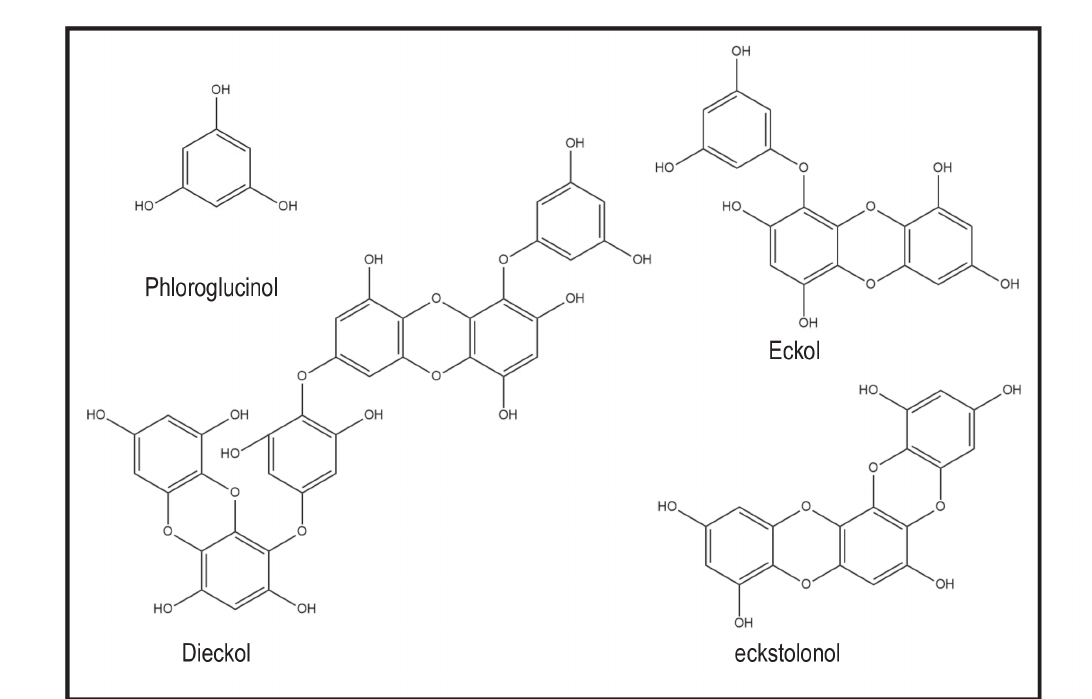
FIGURE 4 - Chemical structure of some common polyphenols phlorotannin type found in